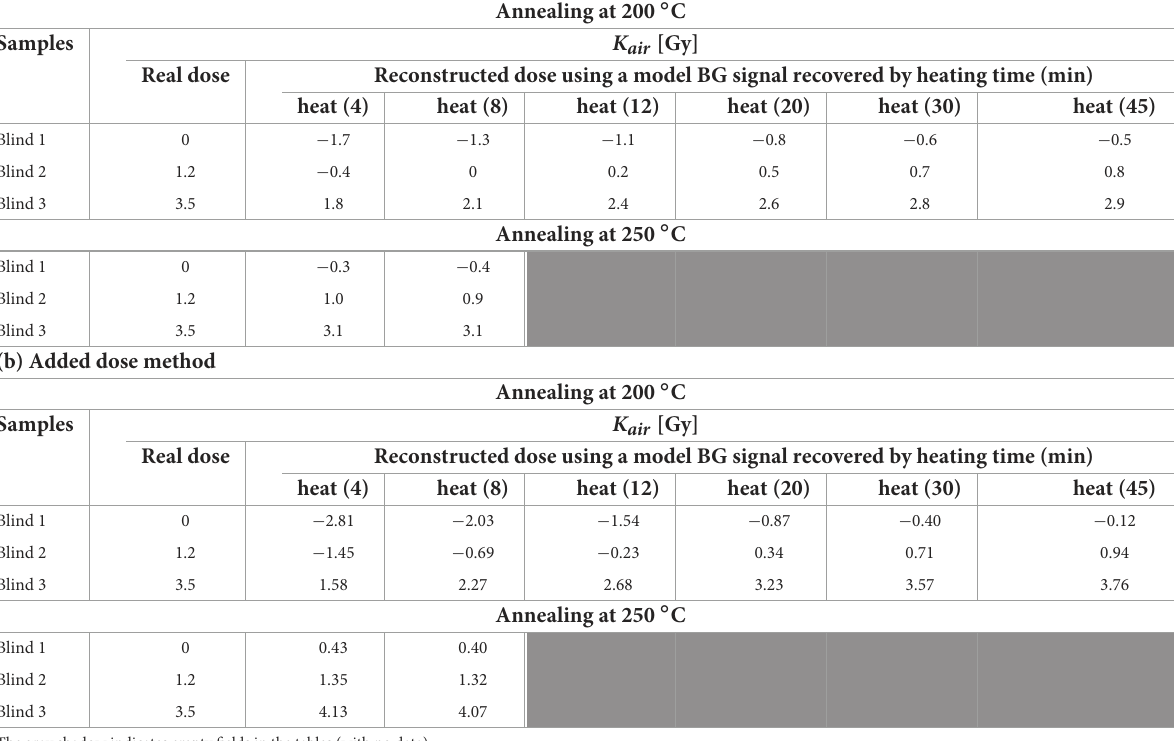
TABLE 2 Comparison of the doses (in terms of kerma in air) reconstructed for 3 blind samples using a model BG signal recovered by heating of irradiated (3.1 Gy) sample for 4–45 min at 200 ◦ C and for 4 and 8 min at 250 ◦ C (a) by calibration method and (b) by added dose method. (a) Calibration method